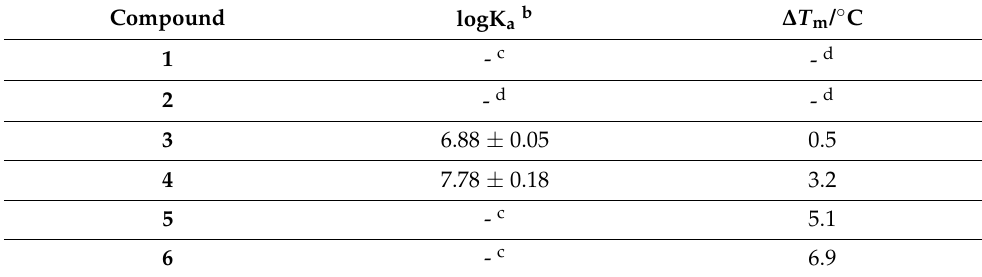
Figure 6. Changes of fluorescence emission of 1–6 ( c = 2 × 10 − 7 mol dm − 3 ) normalized to the last titration point (the highest emission intensity) upon addition of Tel22 (potassium phosphate buffer, I = 0.1 mol dm − 3 , pH = 7.0). Table 3. Binding constants (log K a ) a for 1:1 complexes of 1–6 -Tel22 calculated from the fluorescence titrations and ∆ T m e values (°C) of Tel22 upon addition of ratio f r = 1.0 of 1–6. (potassium phosphate buffer, pH = 7.0, I = 0.1 mol dm − 3 ).